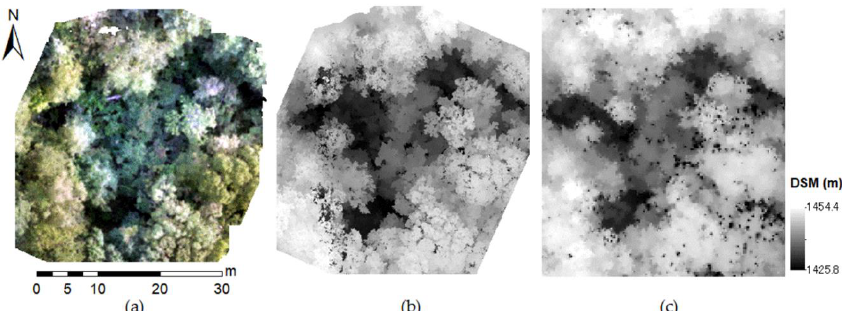
Figure 4. Comparison of digital surface models (DSMs) produced by unmanned aerial vehicle (UAV) photos and LiDAR- 2016. ( a ) Aerial ortho-photo captured by UAV in Aug. 2018; ( b ) DSM based on the UAV aerial photos; ( c ) DSM based on LiDAR-2016 data.